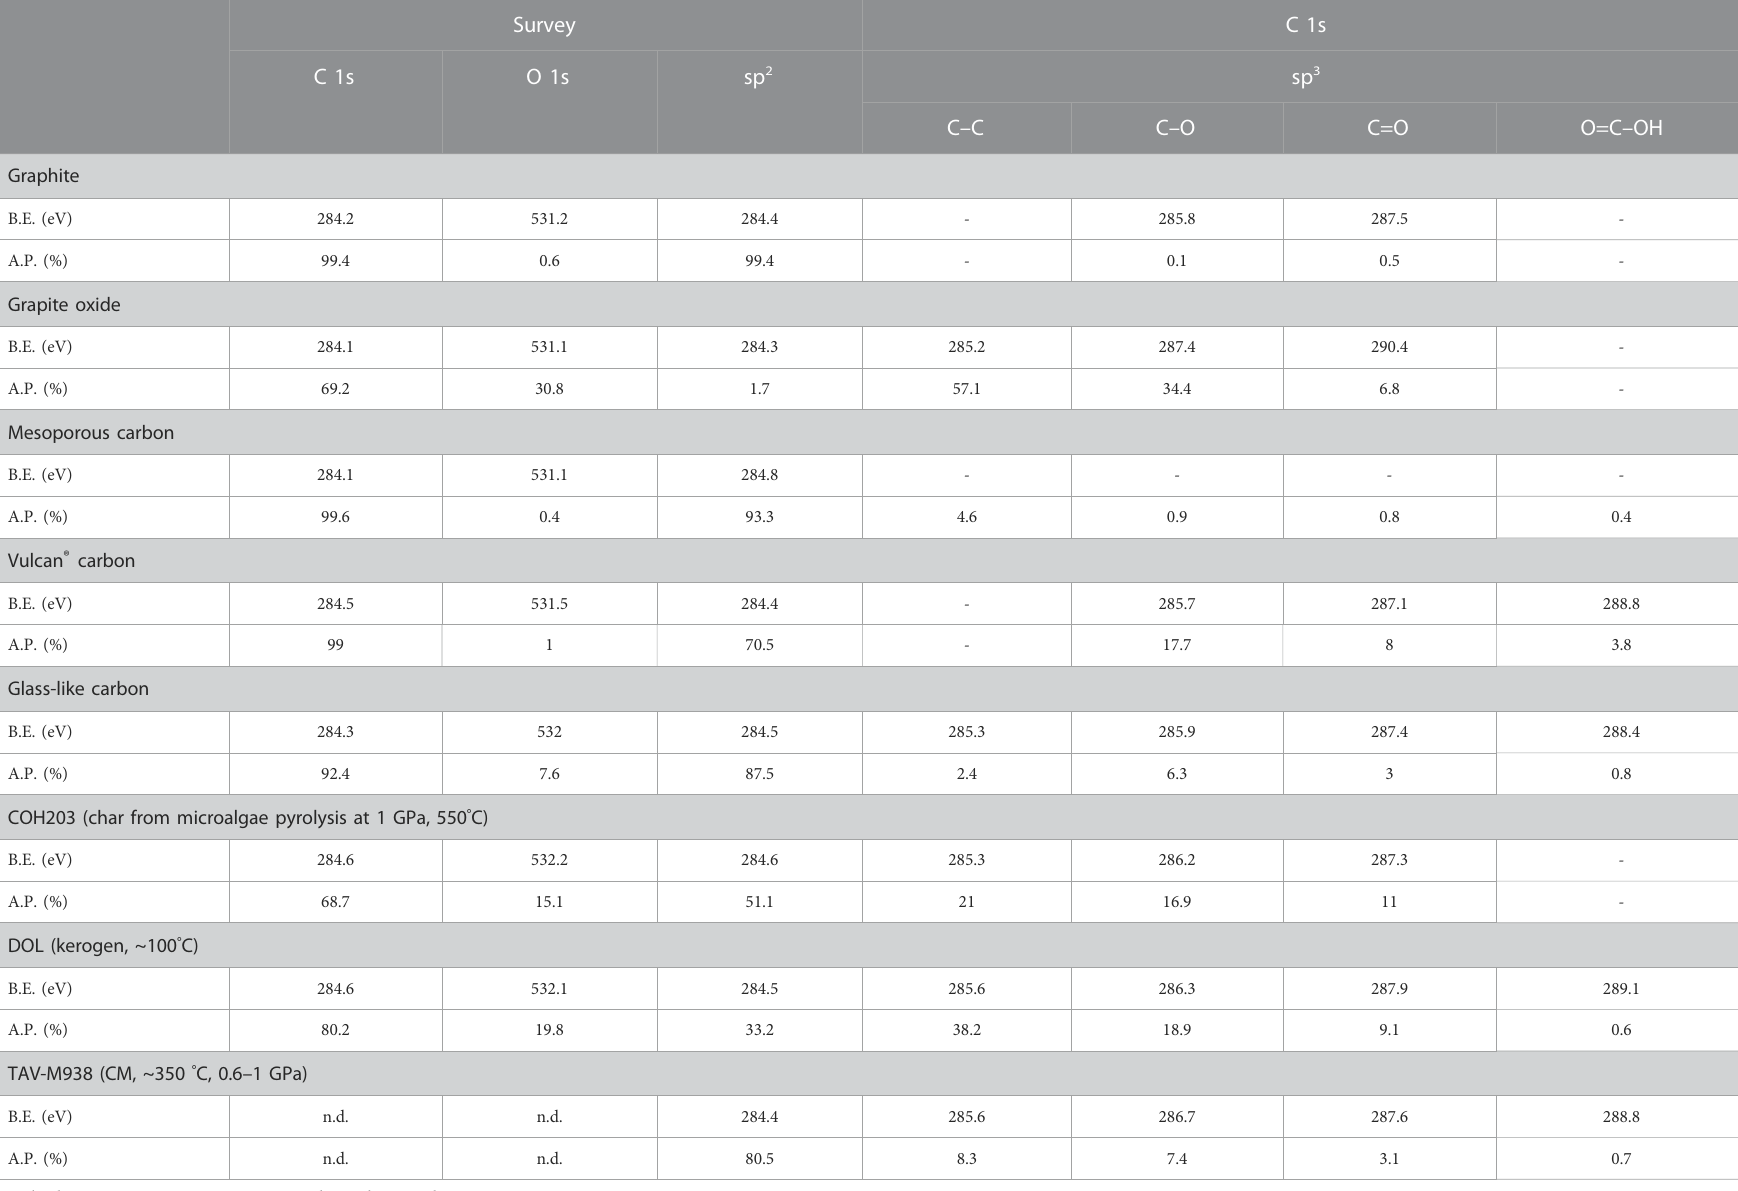
TABLE 4 Results of XPS